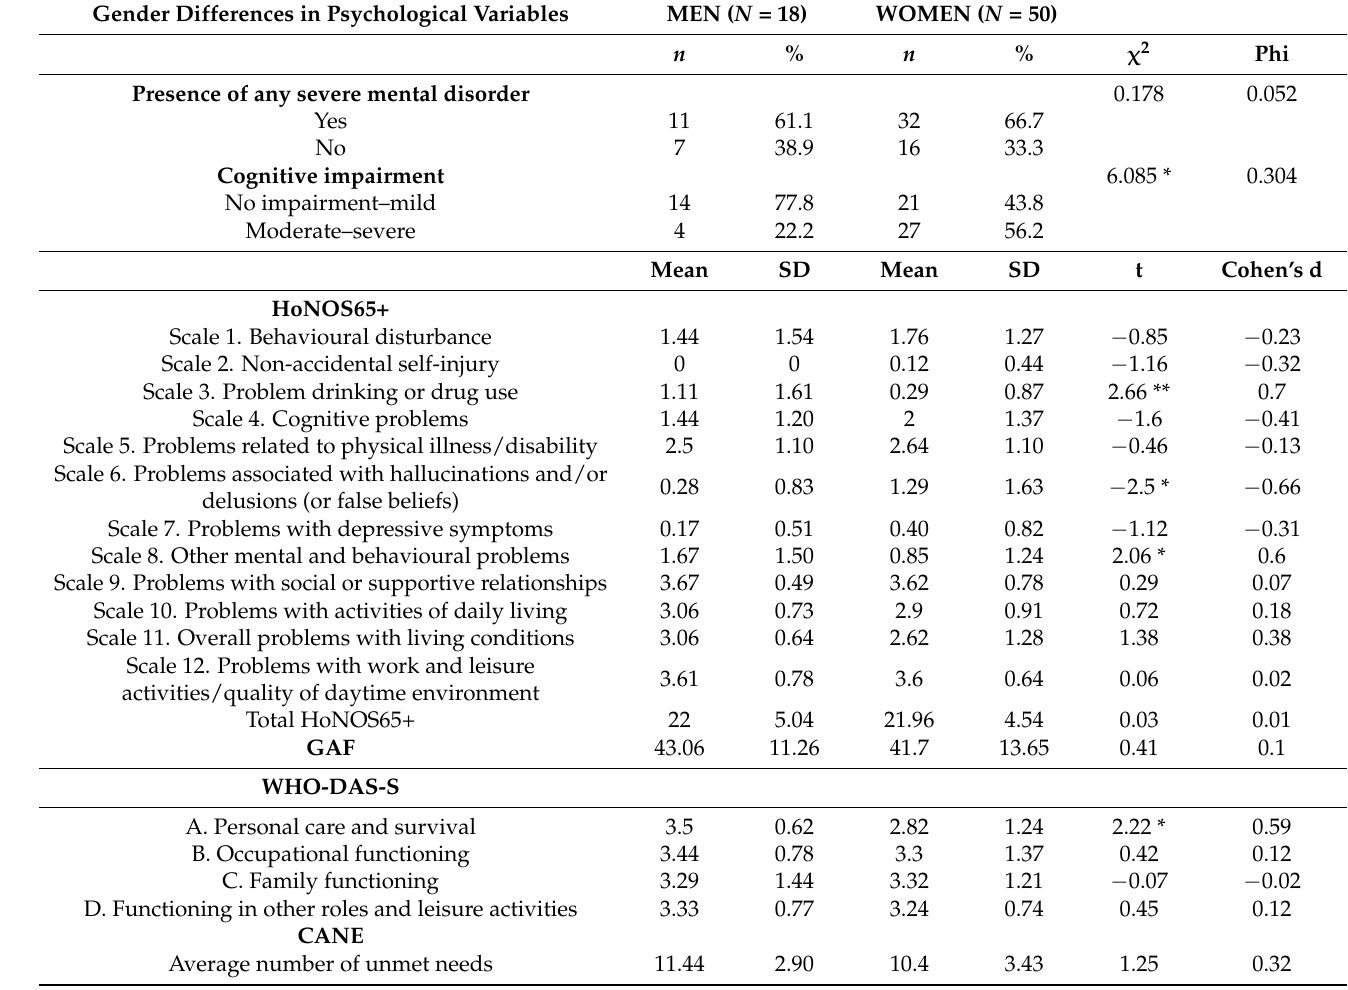
Table 3. Description and analysis of gender differences in psychological